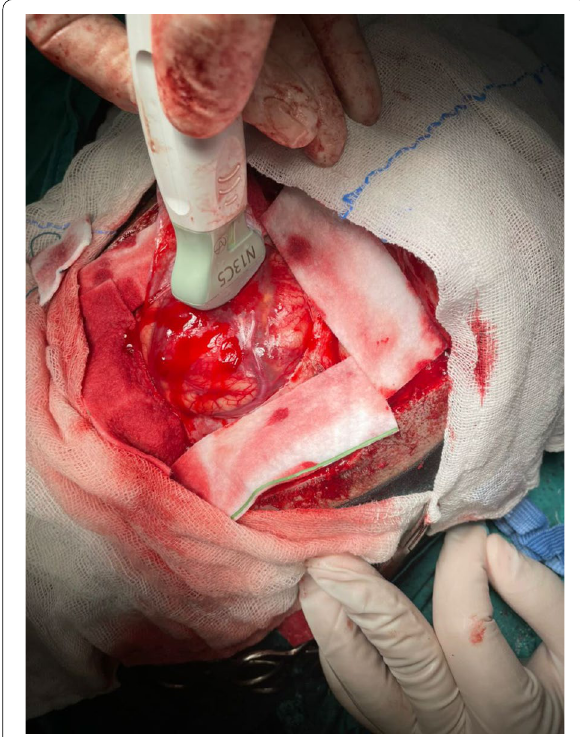
Fig. 4 Use of ultrasound probe after dural incision